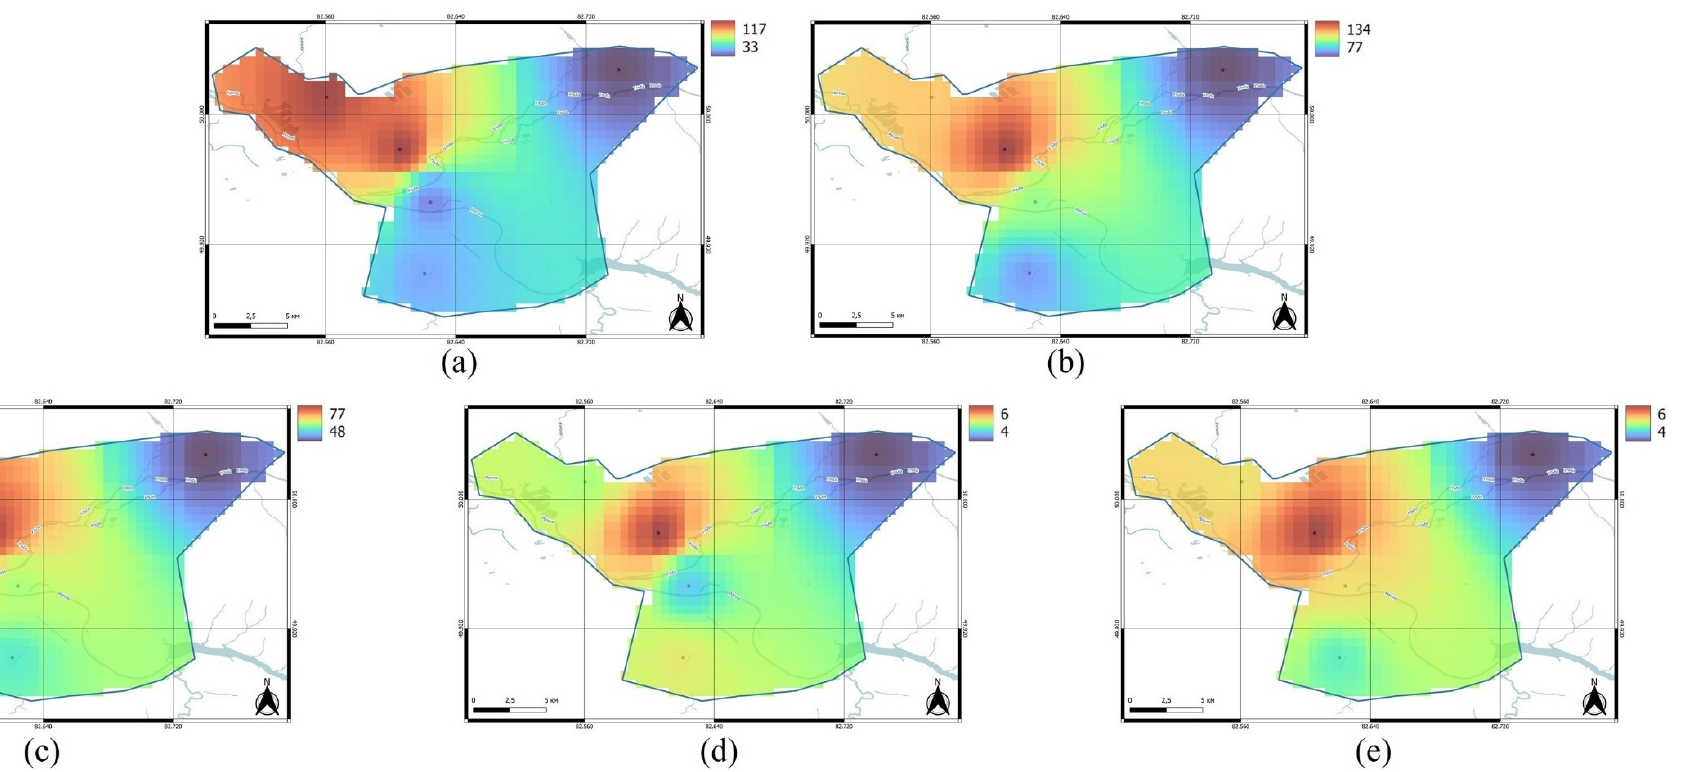
Figure 5. Spatial distribution patterns for ( a ) TSP, ( b ) SO 2 , ( c ) NO 2 , ( d ) HF, and ( e ) formaldehyde during the warm seasons (in μ g m − 3 ).